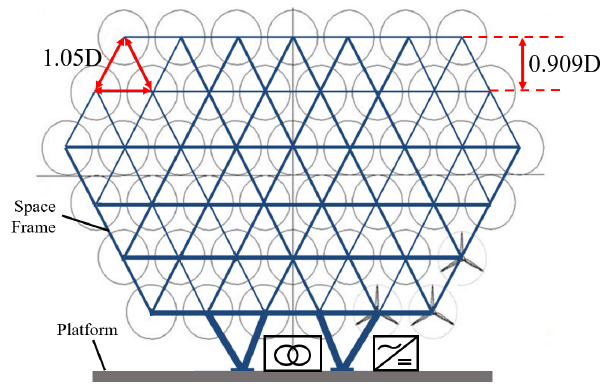
Figure 1. Proposed layout of a 45-rotor MRWT system. Adapted from Jamieson et al.